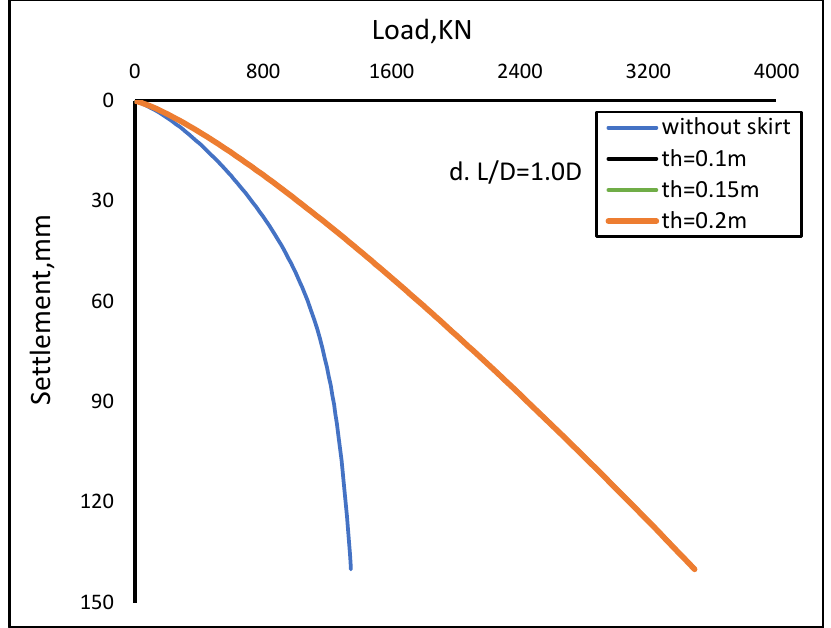
Fig. 6. Load-settlement relationship for skirt circular footing,